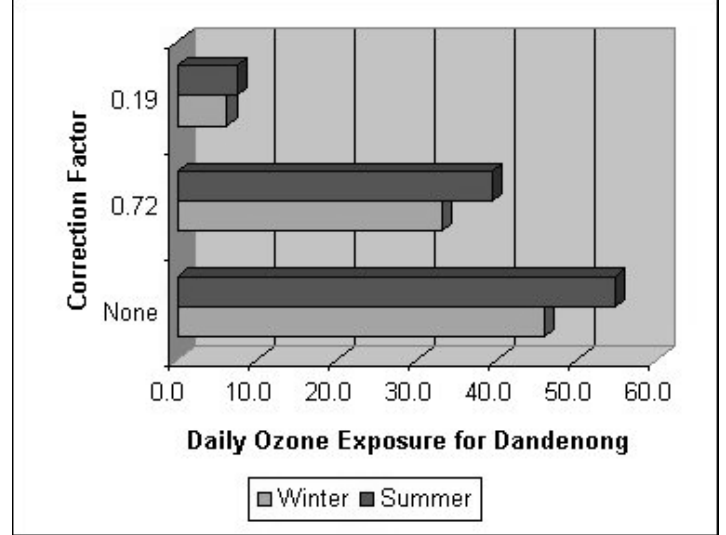
Figure 12. Adjusted ozone exposure for Dandenong (millions of